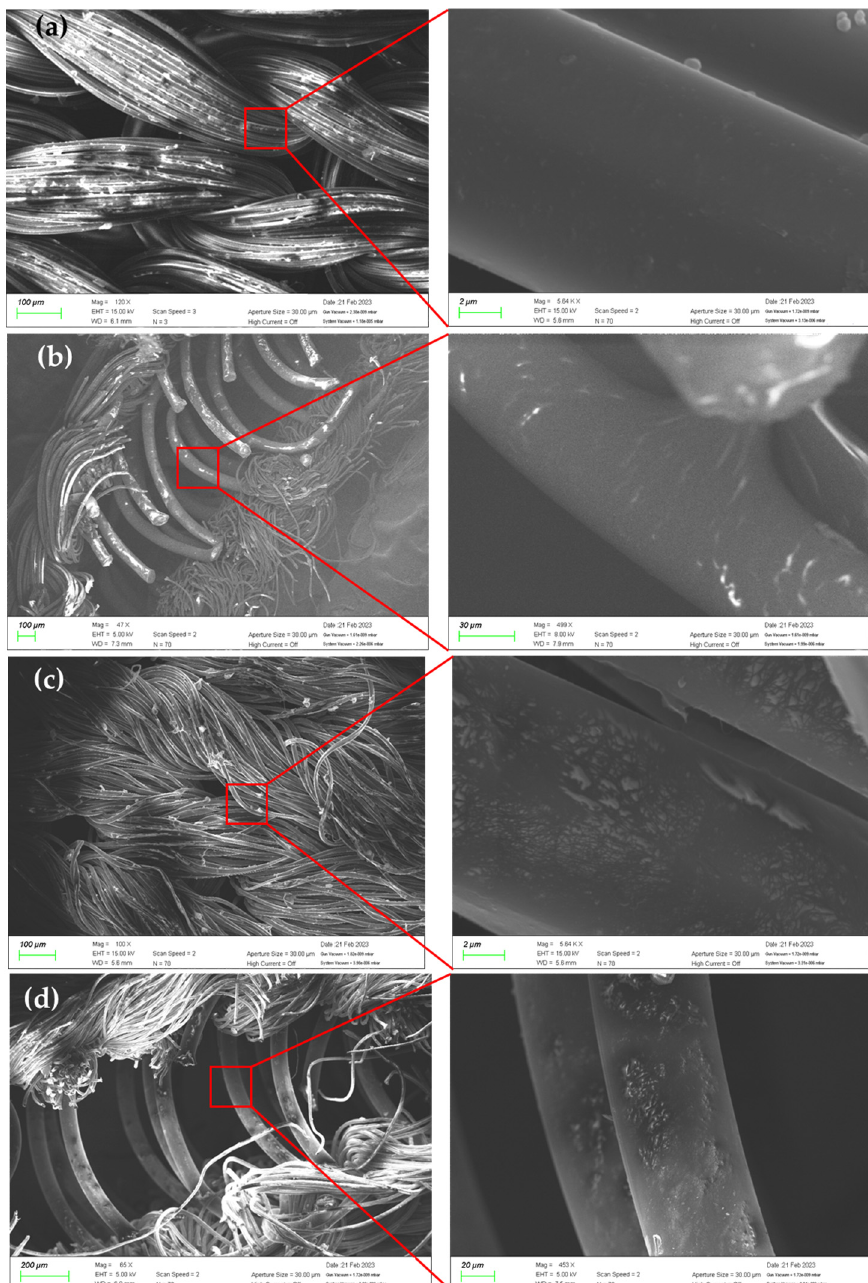
Figure 3. The fabrication process of the textile-based electrode ( a ) top of non-conductive neoprene, ( b ) cross-section of non-conductive neoprene, ( c ) top of conductive neoprene, ( d ) cross-section of conductive neoprene.